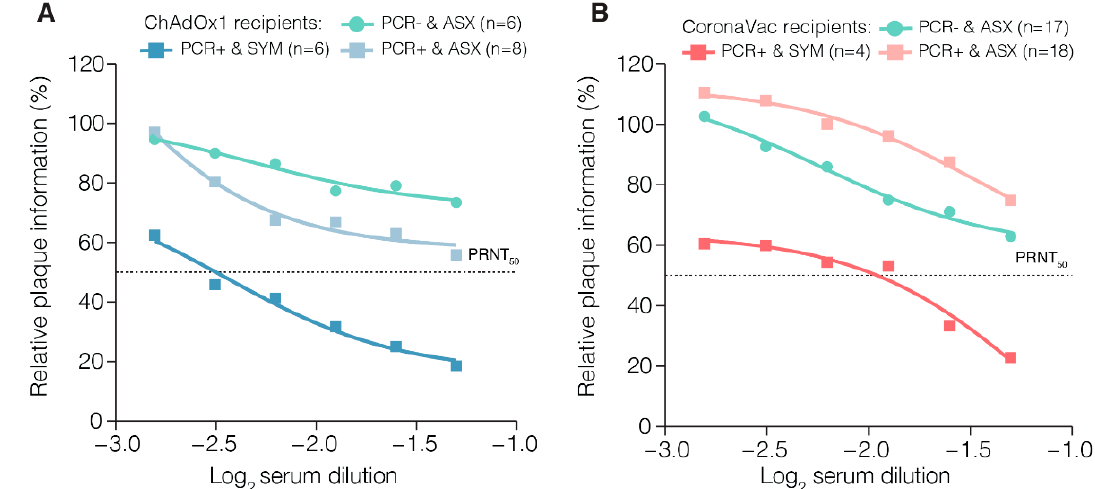
Figure 4. Neutralizing antibodies of sera from individuals vaccinated with ChAdOx1 and CoronaVac against B.1.1.7 isolate. ( A ) Sera from individuals from outbreak A in the convent ( n = 20). ( B ) Sera from individuals from outbreak B in the long-term care facility ( n = 39). The average value in log 2 dilutions of the tested sera are shown. PRNT 50 represents the dilution that showed a 50% reduction in plaque formation in comparison with a control without serum after three-parameter nonlinear regression analysis. The symbols represent the average of sera samples. Abbreviations: SYM, symptomatic. ASX, asymptomatic. PCR+, PCR-positive. PCR − , PCR-negative.